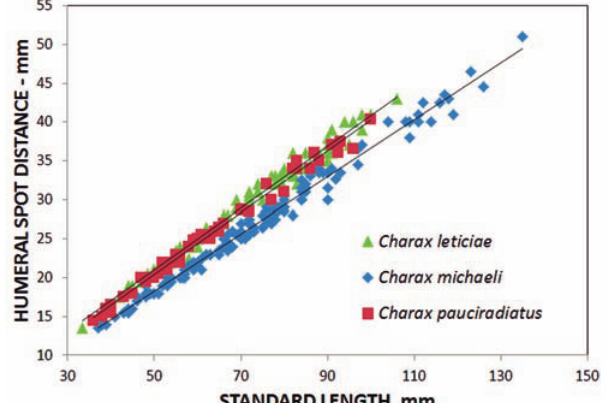
Fig. 2. Superficial neuromasts (black arrow) on ventral body scales of Charax metae , CAS 69117, 59 mm SL.